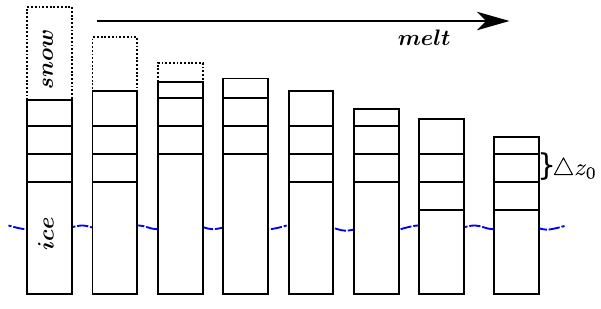
Figure 1. Sketch of SAMSIM grid evolution for three top ice layers during snow melt and following surface ablation as explained in Sect. 2.3.